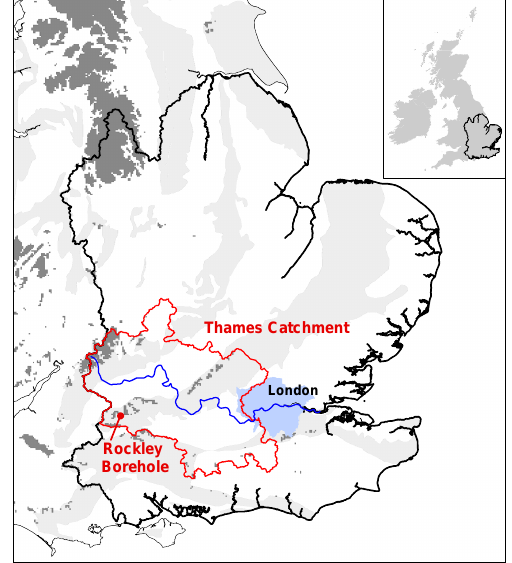
Figure 1. Map of the English Lowlands study region (bold line in- dicates the boundary), the river Thames (blue) and its catchment above the Kingston gauging station (red), and the location of the Rockley borehole (red). For context, the map also shows the loca- tion of London, major aquifers (light grey) and upland areas over 200m (dark